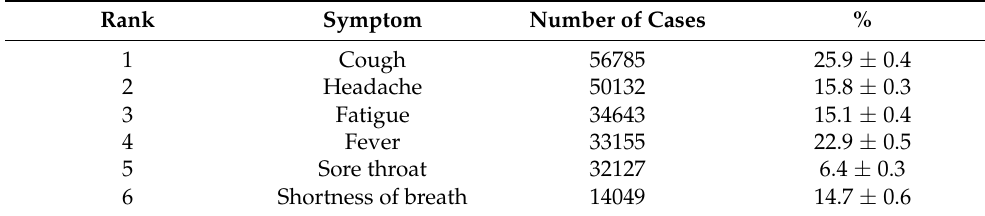
Table 2. Number of cases and percent of total cases with symptoms of cough, headache, fatigue, fever, sore throat and shortness of breath.